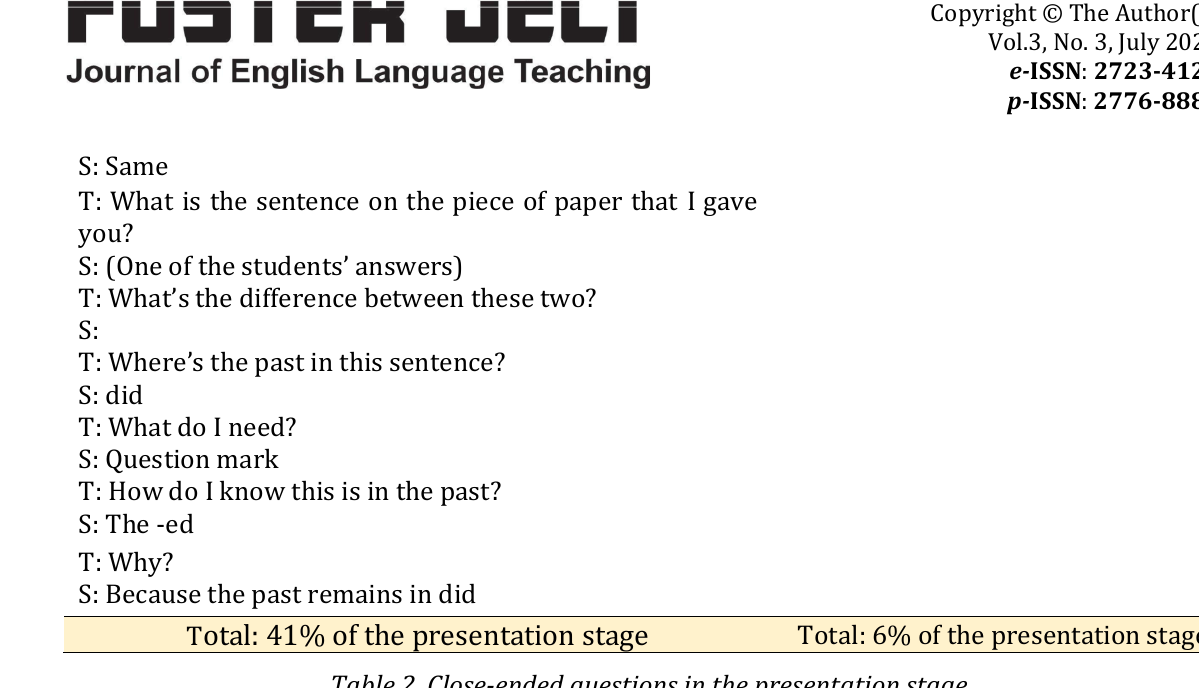
Table 2. Close-ended questions in the presentation stage Yes/no question Giving